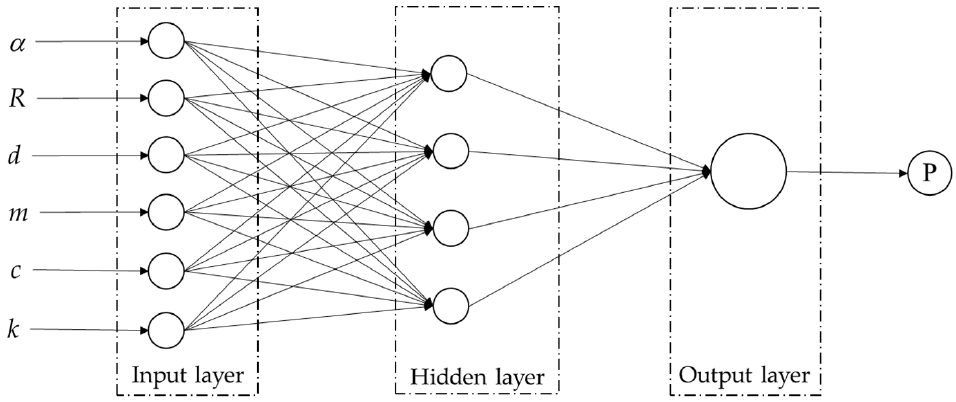
Figure 7. Structure of the designed BP neural network.